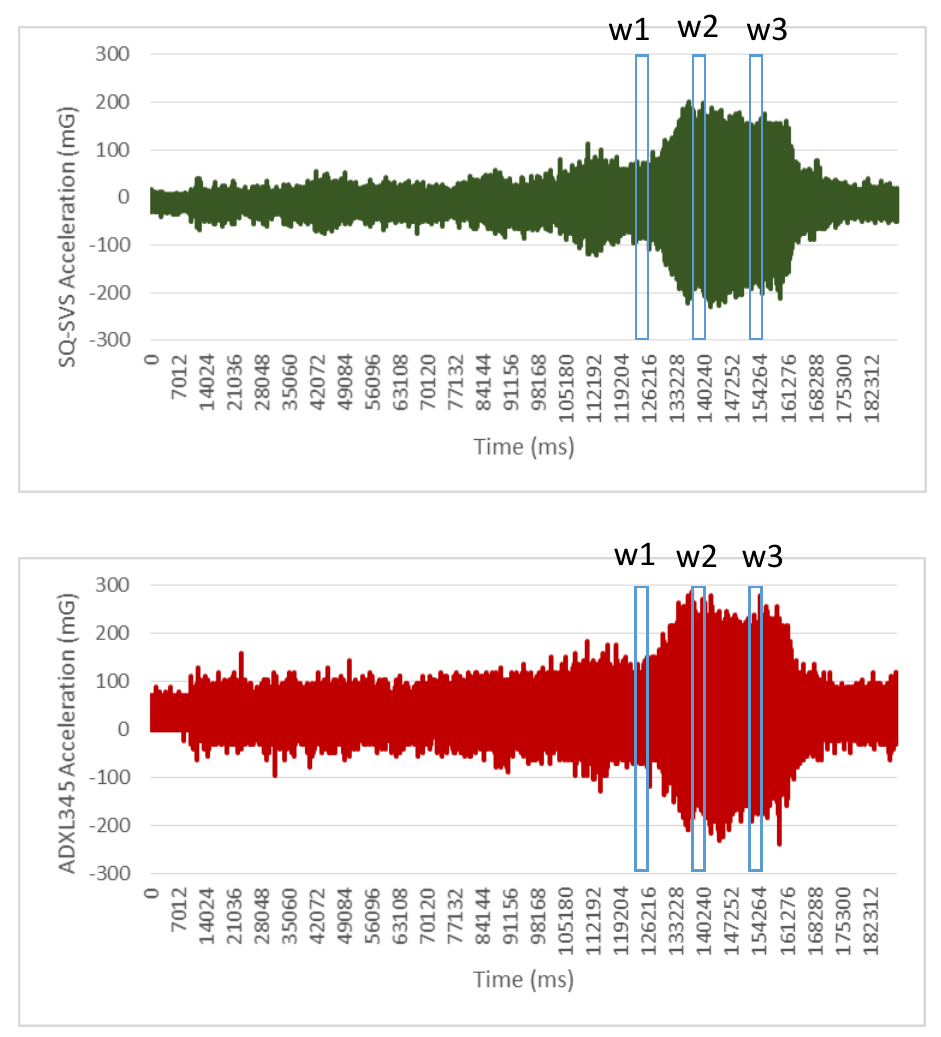
Figure 3. Raw acceleration (axis x) obtained for the sensors SQ-SVS and